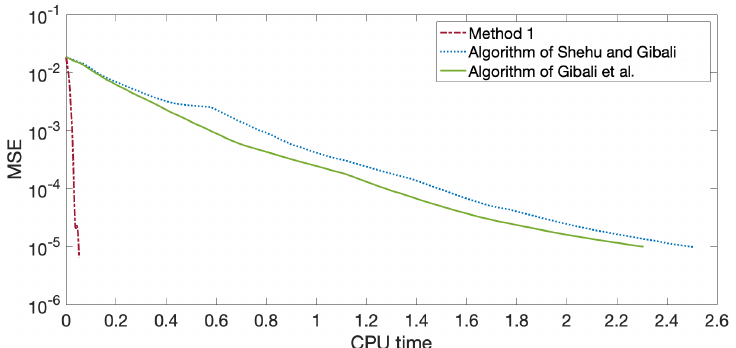
Figure 3. Graph of MSE values and CPU time for P = 2048, K = 1024, m = 30 when MSE < 10 − 5 .